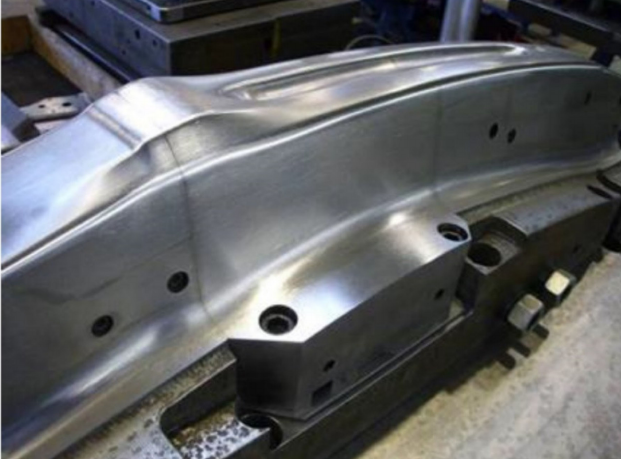
Figure 17. The assembled hot stamping punch [114].